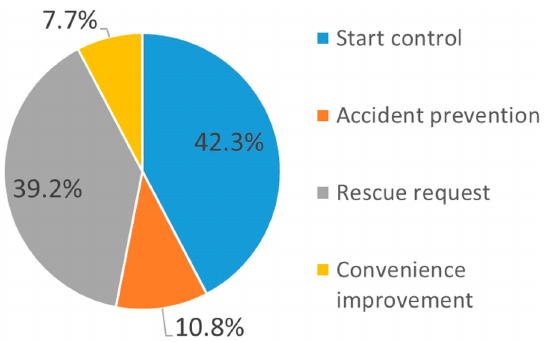
Figure 5. Percentage of smart helmet studies for motorcyclists by sub-category.